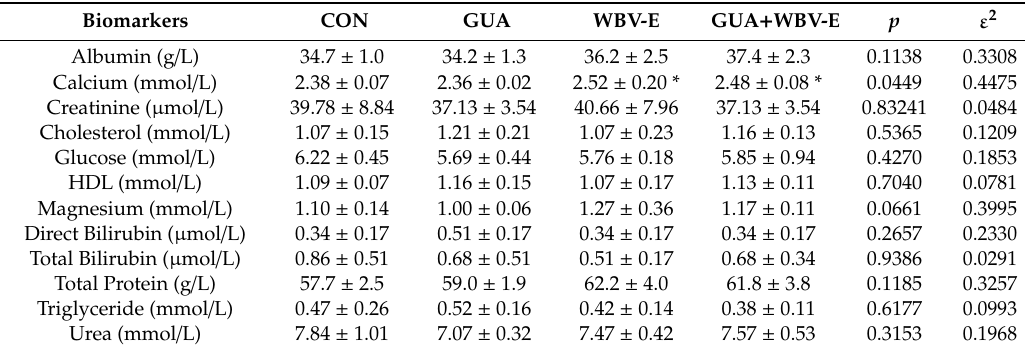
Table 2. Blood biomarkers concentrations of the animals submitted to some interventions.